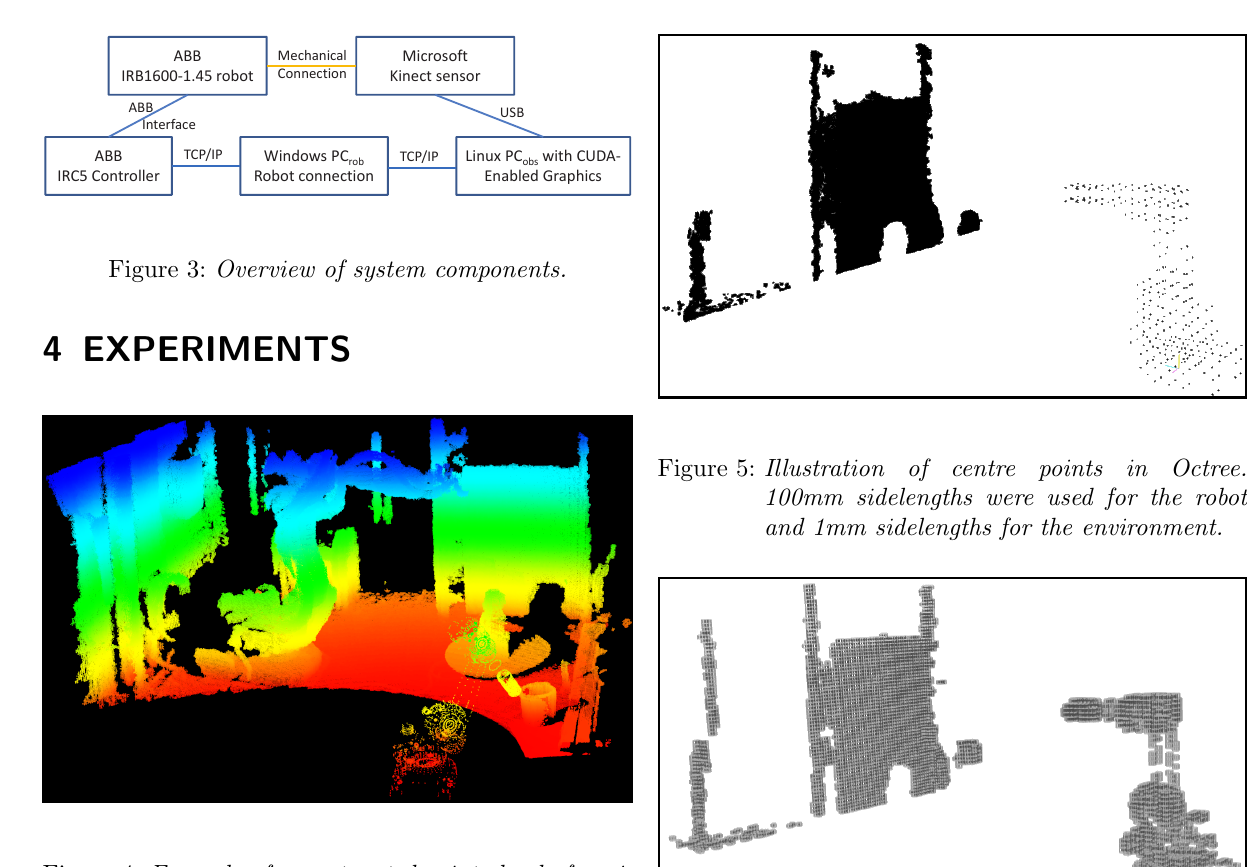
Figure 4: Example of concatenated point cloud of envi- ronment generated with Kinect sensor.